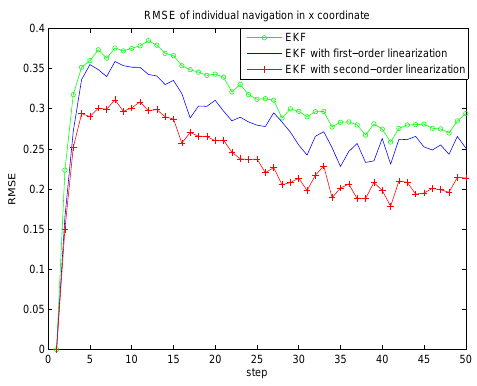
Figure 7. RMSE of individual localization in x coordinate.